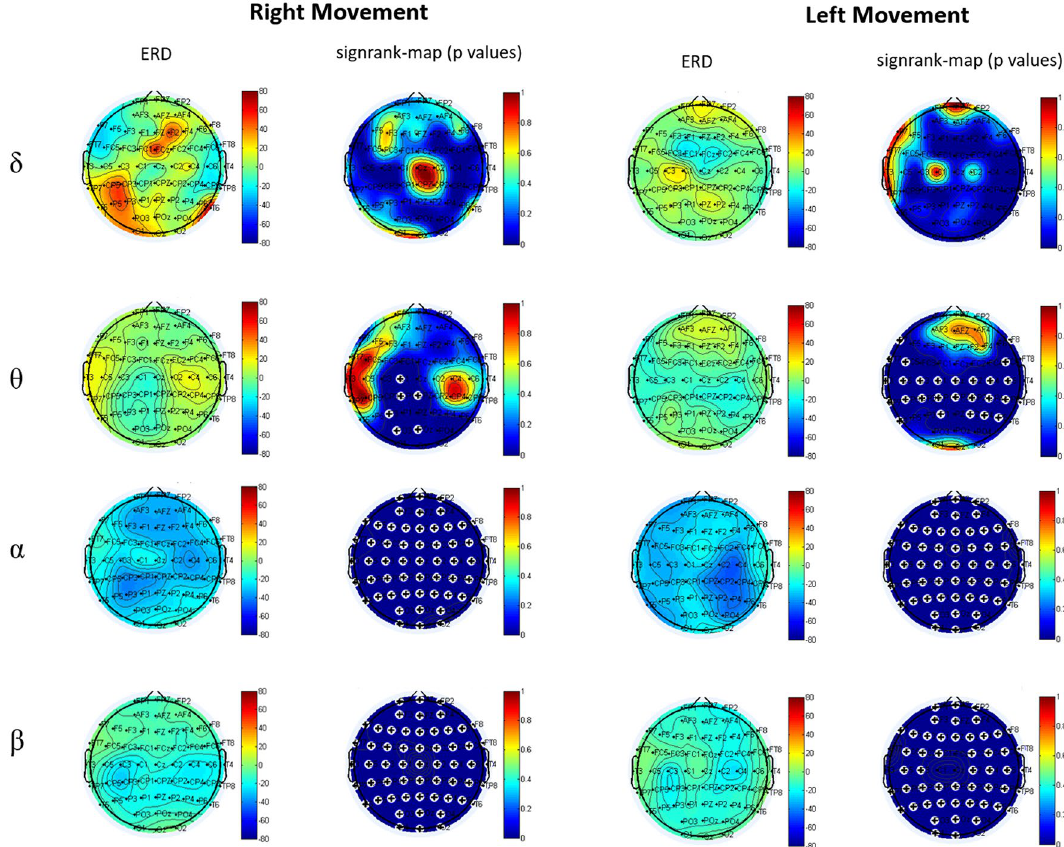
Figure 1. Event-related desynchronization in δ, θ, α, β bands and the relative signrank-maps comparing Movement vs. Rest. The “+” marks indicate electrodes with a significant rest-move difference (the figure was obtained with Matlab R2018 https:// it. mathw orks. com/ produ cts. As expected, ERD/ERS evaluation showed a widespread bilateral desynchronization in α band and secondarily in β band, mainly over the somatosensory and motor areas during both the right and left movements 28,29 . In θ band we observed a different behaviour between the right and left movements, being θ activity bilaterally desyn- chronized on the centro-parietal electrodes during the left movement while during the right movement ERD was only observed on the contralateral centro-parietal electrodes. The coherence analysis showed very interesting results. Summing up, we noticed a coherence reduction among ROIs during the movement compared to the rest state mainly in α band for both arms. However, when analysing the pairs of ROIs with reduced coherence during the movements, we observed a different behaviour between right and left arm movements. In particular, the left arm movement was associated to the modulation of coherence among the right occipital regions, the insular cor- tex and the somatosensory cortex. On the other hand, we did not observe the same involvement of the occipital cortex during the right movement. This probably means that the movement performed with the non-dominant arm (left arm in our subjects) requires a higher visual control. The insular cortex has been demonstrated to be involved in different processes as touch processing 30 , integration of limb and field coordinates 31 , motor planning 32 and error awareness 33 . In this context, it seems that the insular cortex, together with the proprioception control exerted by the somatosensory cortex 34 and the visual control 35 , is pivotal in performing a finalistic motor task as reach&grasp with the—non-dominant arm. The hypothesis of the left movements being a less automated process than the right, dominant one is also supported by changes in FC between the right BA9 and BA39, both involved in intentional executive control of behaviour in general and movement in particular 36 . Moreover, the right BA39 is also involved in the visuospatial processing, which allows object localization 37 . Left (non-dominant) movement is associated with a complex and widespread contralateral cortical fronto-temporo-parieto-occipital network with probably a top-down control process involving executive functions. This view is in line with the concept of the “attentional landscape” which represents that attention space which computes all relevant information representing the pre requisite for properly planning and performing a complex movement 38,39 . Our observa- tions suggest that the planning of a movement with the non-dominant side, which is more challenging for the subject, requires an attention effort and enacts an integrated cortical network which drives the motor action for obtaining a performance similar to that of the dominant side (as the kinematic measurements demonstrate). On the other hand, the right (dominant) movements do not seem to activate such a widespread contralateral network, being in this case involved the primary somatosensory cortex (areas BA2 and BA3), premotor and supplementary motor cortex (BA6), primary motor cortex (BA4), temporal lobe (BA20 and BA38) and dorsal